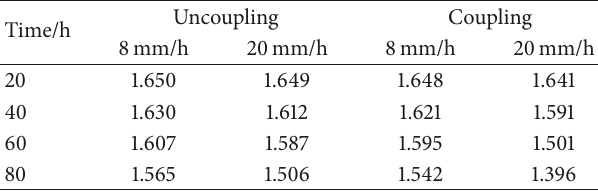
Table 3: Comparison of factors of stability for different conditions.